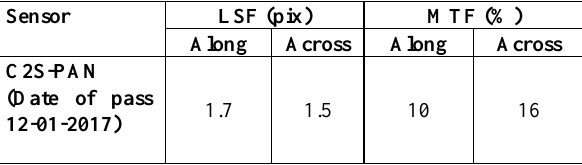
Table 4.Edge based LSF & MTF values for C2X-PAN sensor.